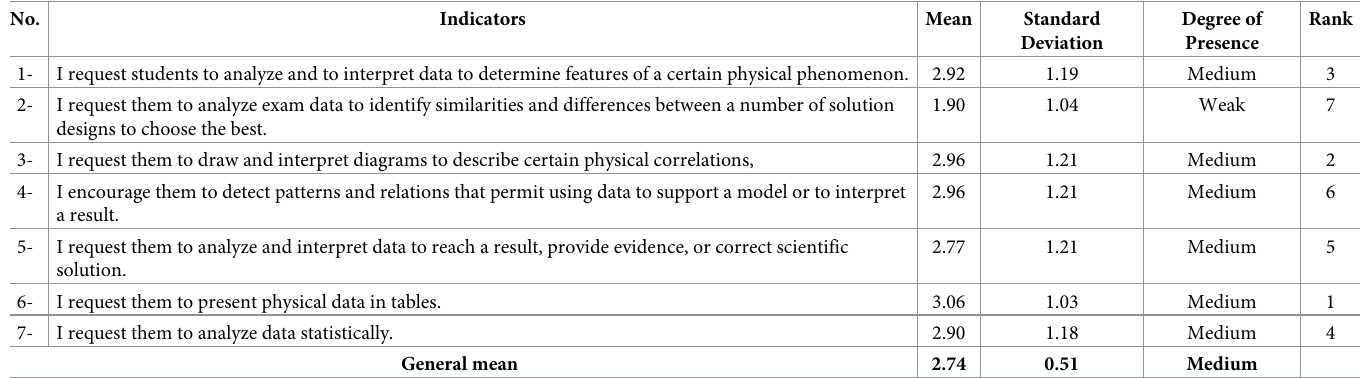
Table 5. The means and standard deviations of the presence of the “analyzing and interpreting data” practice.